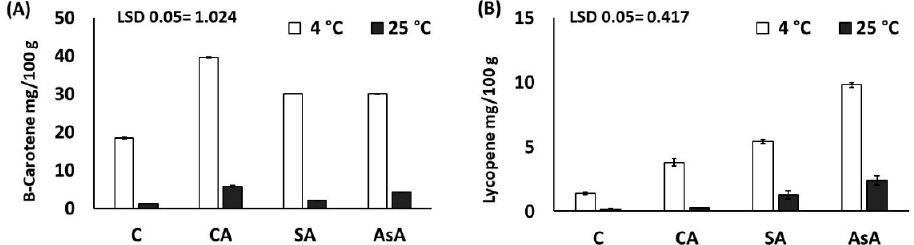
Figure 12. Effects of bio-stimulants B, control (C), citric acid (CA), salicylic acid (SA) and ascorbic acid (AsA) and storage temperature T (4 °C and 25 °C) on beta-carotene content ( A ) and lycopene content ( B ) of okra pods stored for 12 days. Error bars are the ±SD of the means of three biological replicates. LSD values ( p ≤ 0.005) for B= 0.181, T = 0.128. ( B ) B = 0.295, T = 0.209. LSD for B ×T is presented on the figure.